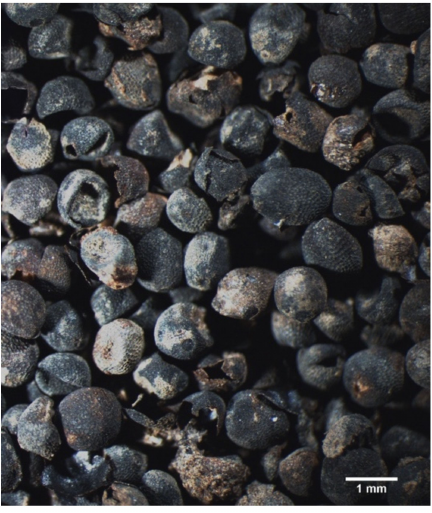
Figure 5. Brassica sp.pl. seeds from context I (Ferrara—no. 16c). Photograph: L. Dal Fiume.